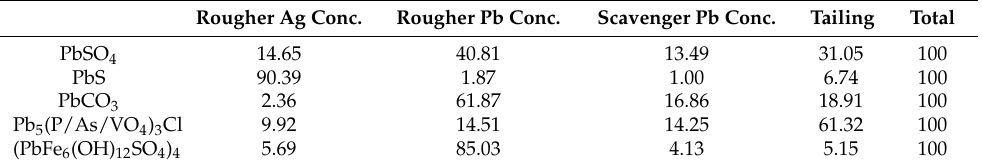
Table 5. The recovery rate of Pb (%). Rougher Ag Conc. Rougher Pb Conc. Scavenger Pb Conc.